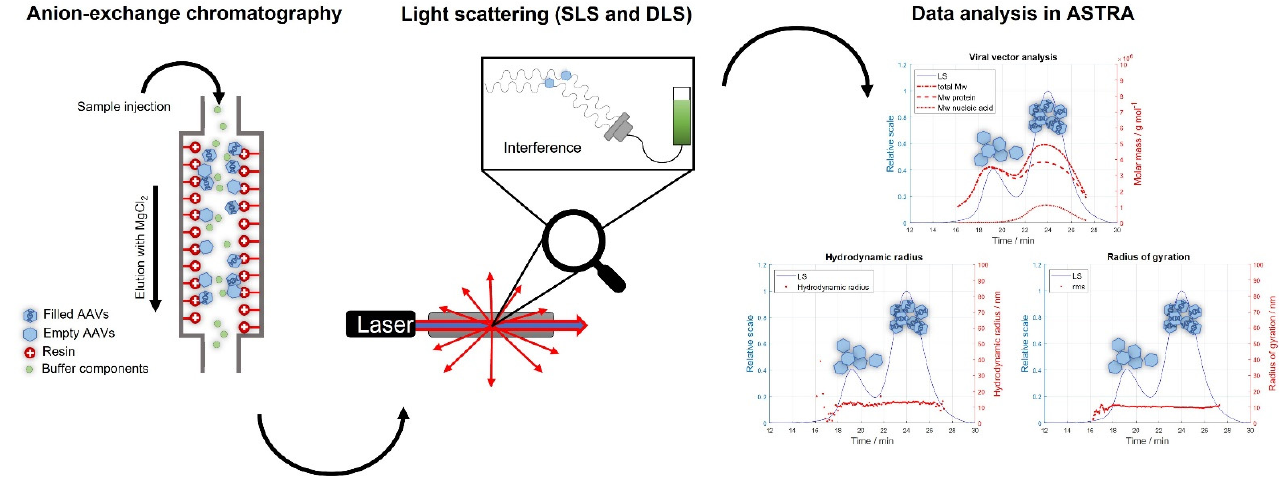
Figure 1. Schematic illustration of the IEC-MALS method. The AAV sample is loaded onto the anion-exchange column, eluted with a salt gradient containing MgCl 2 and detected with multi-angle light scattering and UV detectors prior to data analysis using ASTRA software.